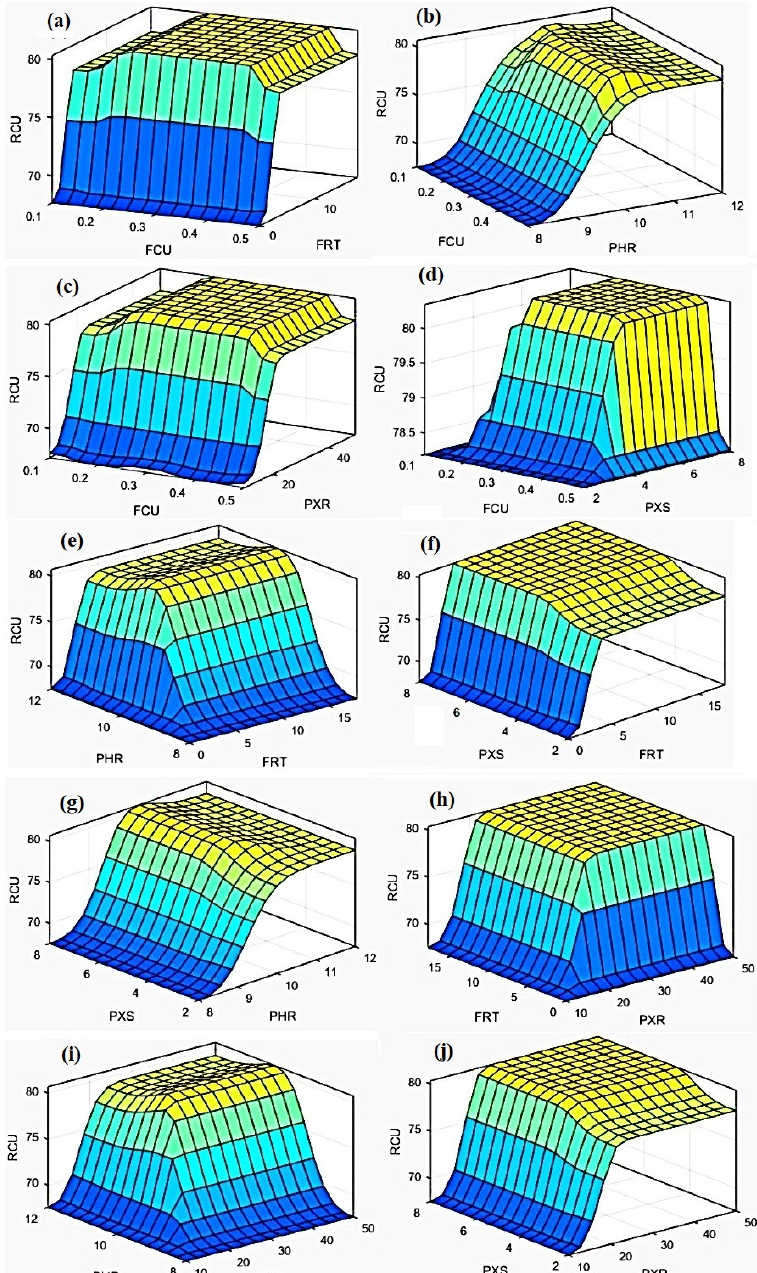
Figure 8. Resulting response surfaces of the PMM model—dependence of copper recovery in final concentrate (RCU) on input parameters. ( a ) copper content in the feed (FCU) and frother consumption (FRT); ( b ) copper content in the feed (FCU) and pH value of slurry at rougher flotation circuit (PHR); ( c ) copper content in the feed (FCU) and collector consumption at rougher flotation circuit (PXR); ( d ) copper content in the feed (FCU) and collector consumption at scavenger flotation ciruit (PXS); ( e ) frother consumption (FRT) and pH value of slurry at rougher flotation circuit (PHR); ( f ) frother consumption (FRT) and collector consumption at scavenger flotation ciruit (PXS); ( g ) pH value of slurry at rougher flotation circuit (PHR) and collector consumption at scavenger flotation ciruit (PXS); ( h ) frother consumption (FRT) and collector consumption at rougher flotation circuit (PXR); ( i ) pH value of slurry at rougher flotation circuit (PHR) and collector consumption at rougher flotation circuit (PXR); ( j ) collector consumption at scavenger flotation ciruit (PXS) and collector consumption at rougher flotation circuit